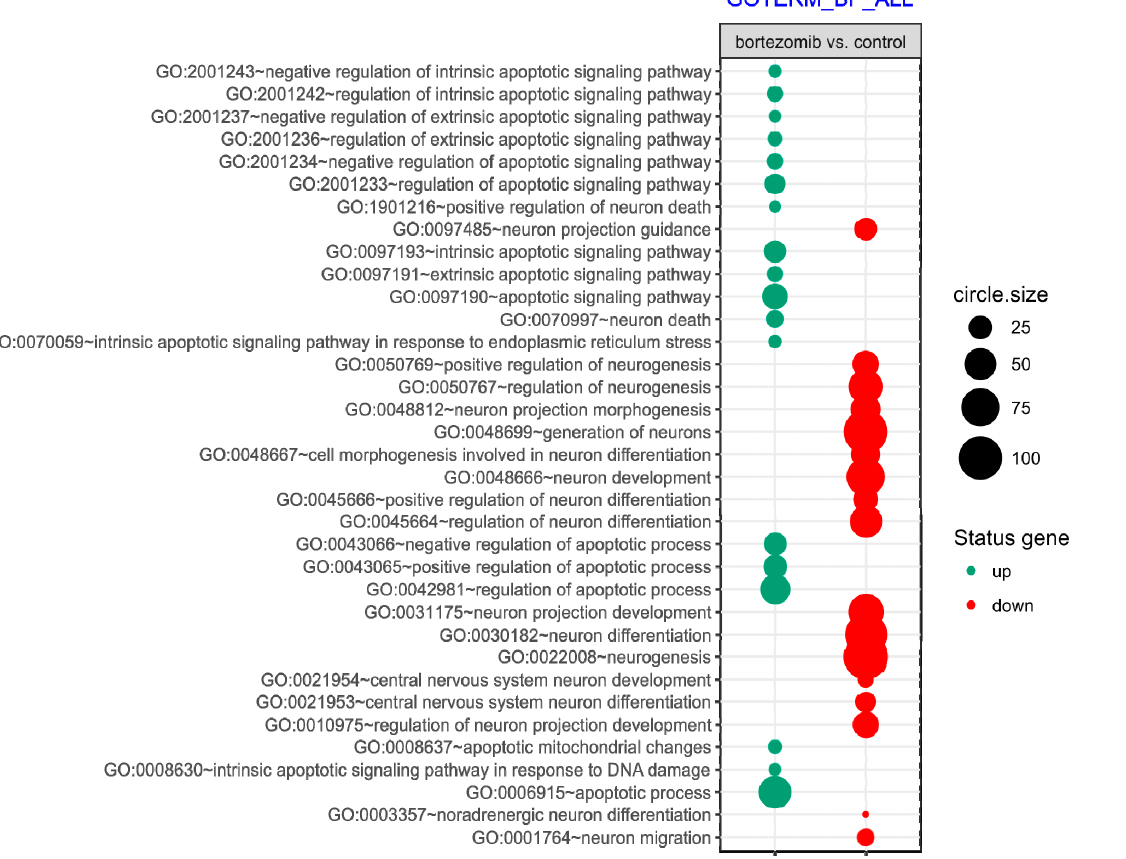
Table 1. The list of 15 most downregulated genes involved in neurogenesis in bortezomib-treated SH- SY5Y cells compared to controls. Gene function according to NCBI Gene